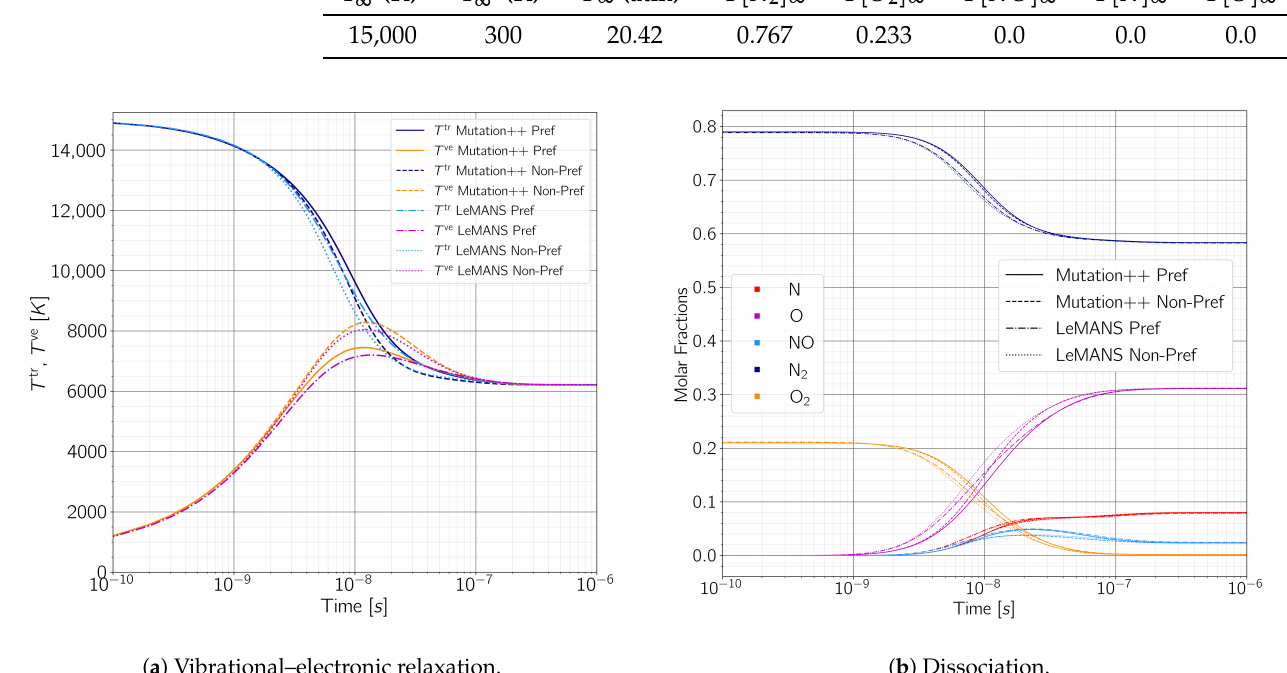
Figure 5. Air-5 thermal bath thermochemical nonequilibrium